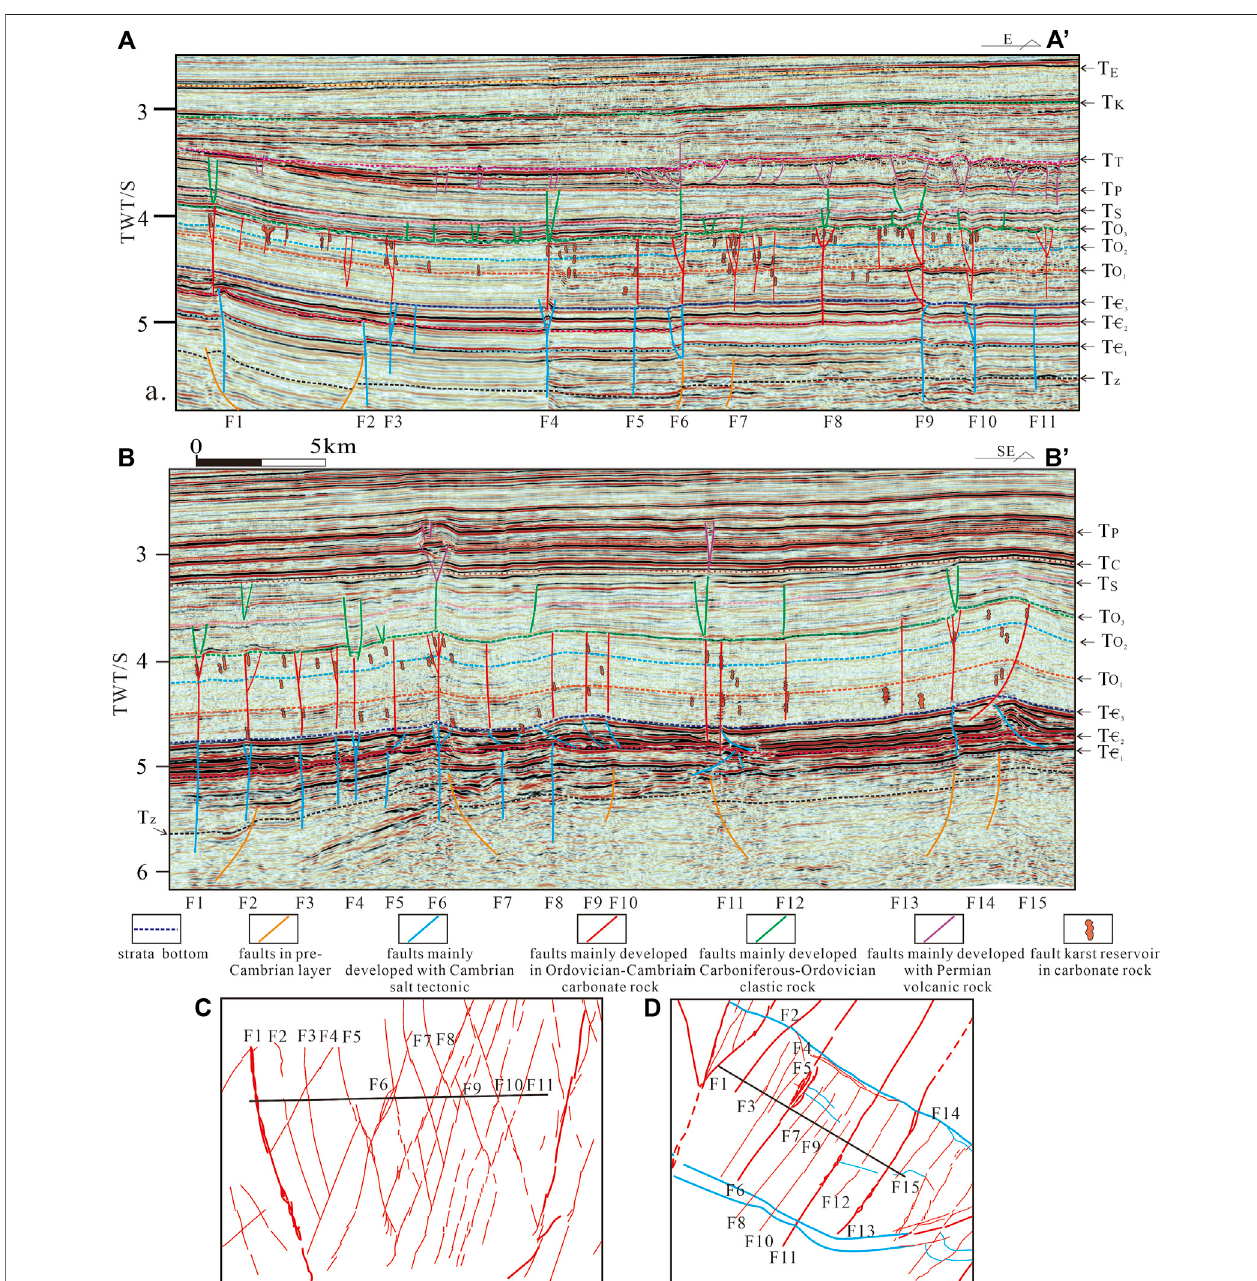
FIGURE 6 | (A) Characteristics of layered deformation of typical 3D seismic pro fi les across strike-slip faults within the Tabei uplift (for location, see Figure 5 ). (B) Characteristics of the layered deformation of typical 3D seismic pro fi les across strike-slip faults within the Tazhong uplift (for location, see Figure 5 ). (C) Seismic line location map and fault system of the Tabei uplift. (D) Seismic line location map and faultsystem of the Tazhong uplift. Please refer to the supplementary materials for the uninterpreted seismic data.